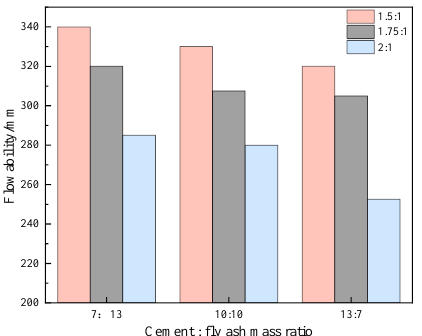
Figure 4. The fluidity of the lightweight CLSM.